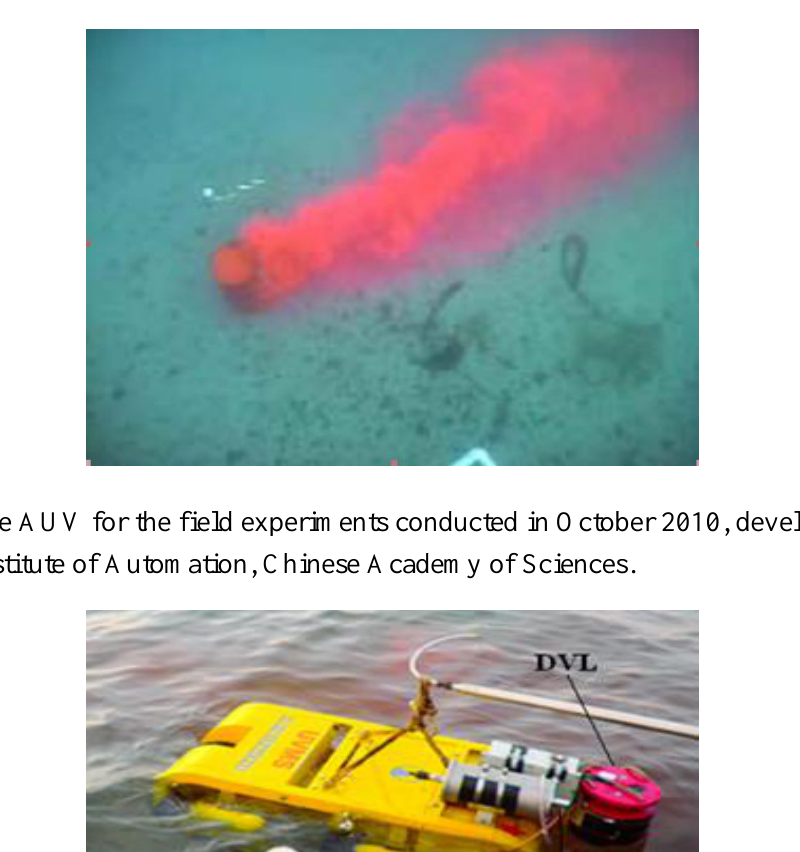
Figure 5. Rhodamine dye plume in the vincity of its source location (November 2002 at